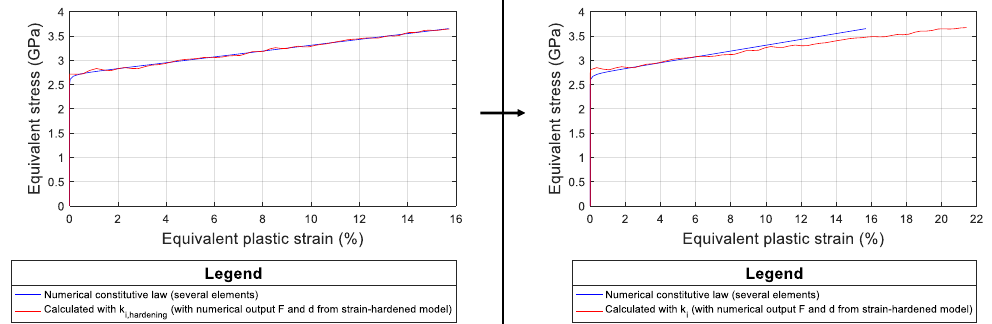
Figure 8. Comparison of numerical ( σ eq,num − ε eq,num ) response averaged in the ligament of a numerical simulation involving a sample with strain-hardening to the ( σ eq,calc − ε eq,calc ) response obtained by applying the processing method to the numerical force and displacement extracted from the numerical simulation. Left : use of 𝑘 𝑖,hardening parameters (Table 8), Right : use of 𝑘 𝑖 parameters (Table 6).